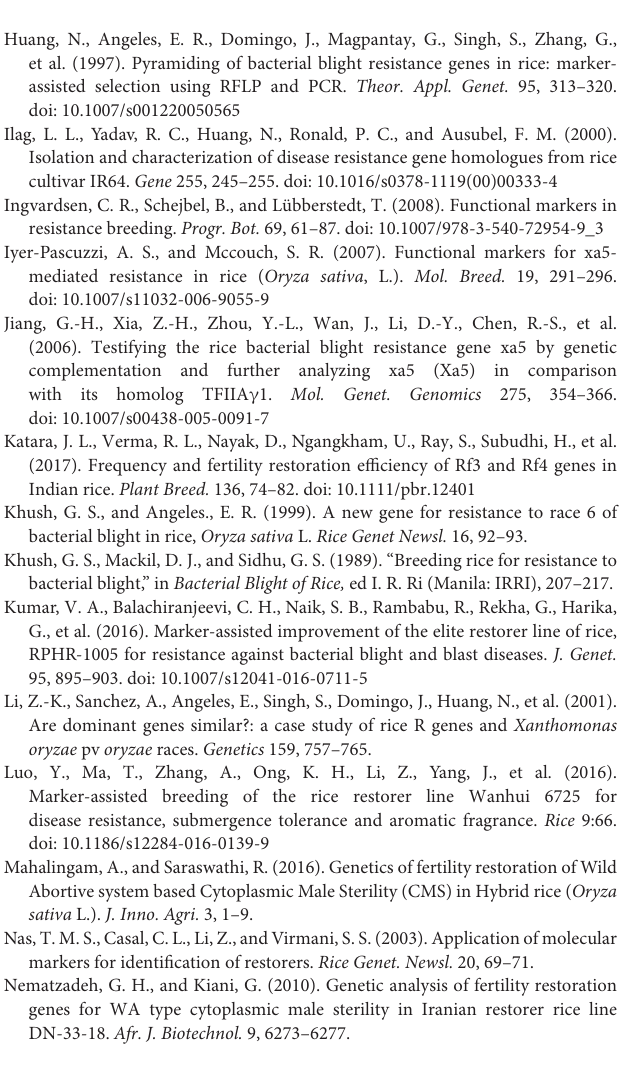
Table S1 | Comparative hybrid yield performance from the cross of BB improved CMS line and identified BB improved R